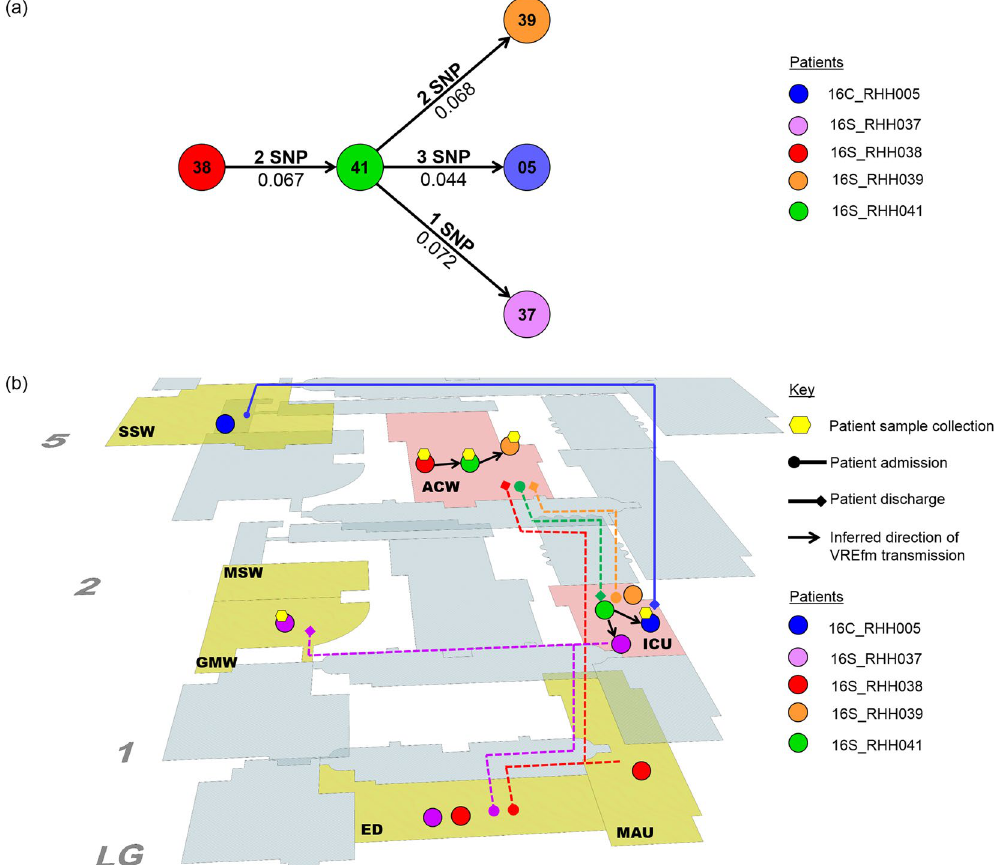
Figure 5. Vancomycin-resistant Enterococcus faecium (VREfm) transmission analysis based on single nucleotide polymorphism (SNP) genotypes of Phylogenetic Clade 1 (PC1). ( a ) Inferred VREfm transmission directions are represented by line connections between patients. Phylogenetic relationship is measured by differences in unique SNPs (numbers above connecting lines) and patristic distances between the isolates (numbers below connecting lines). ( b ) Correlation of SNP genotype data with epidemiological data revealed likely direction of transmission and potential points of transmission within the hospital. Potential points of transmission of PC1 vanB ST796 VREfm are indicated (pink areas). The Intensive Care Unit (ICU) was identified as the most likely location where transmission of VREfm occurred to patient 16C_RHH005 who presented with clinical symptoms of a urinary tract infection. Additional hospital units where patients from this cluster were located are indicated (yellow areas). Hospital ward abbreviations: ACW, acute cardiac ward; ED, emergency department; GMW, acute general medicine ward; ICU, intensive care unit; MAU, acute medical admissions unit; MSW, acute medical specialties ward; SSW, acute surgical specialties